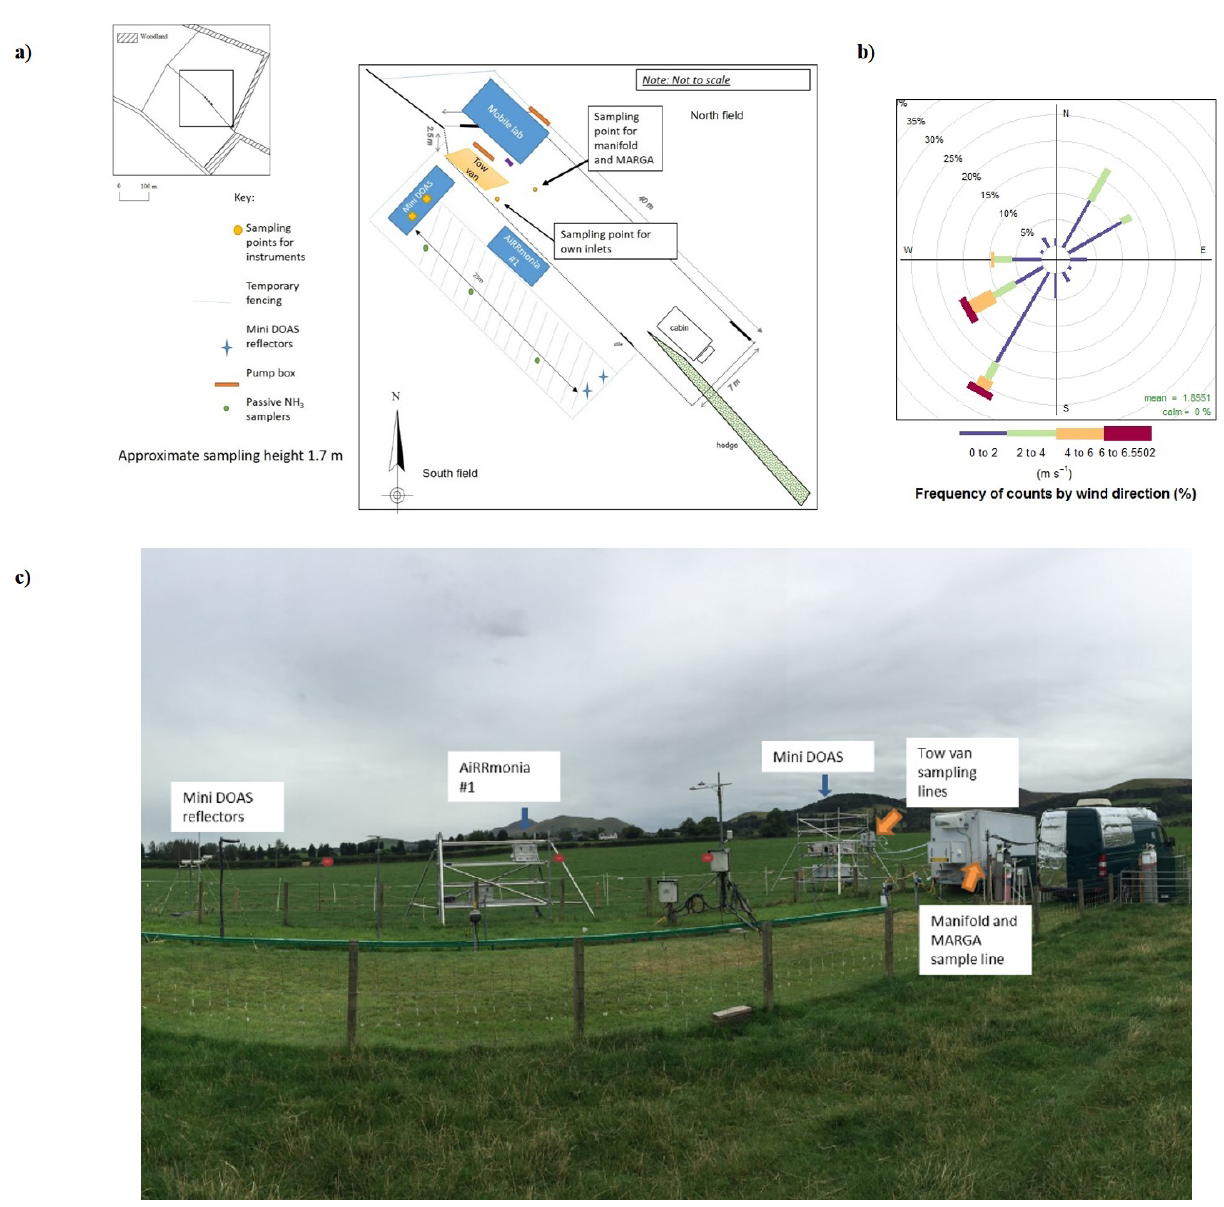
Figure 1. (a) Layout of field site, (b) wind rose of wind direction and wind speed for the period 23 to 29 August (generated using OpenAir package in R; Carslaw and Ropkins, 2012), and (c) photo of set-up instruments (photo credit: Mhairi Coyle,